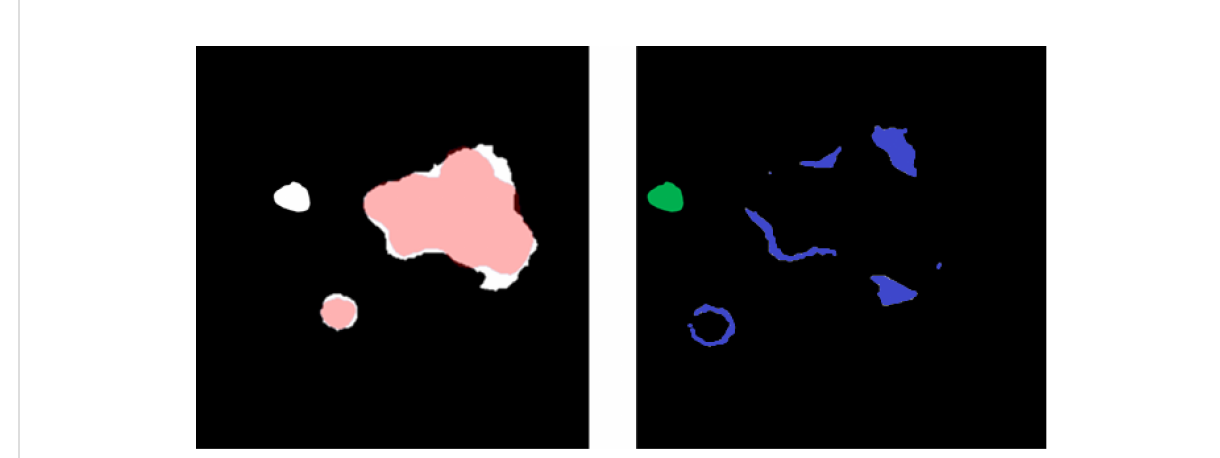
FIGURE 5 (Left) Overlay between predicted (white) and ground-truth (red) disease segmentations. (Right) Subtraction of the predicted and ground-truth disease segmentation and over-segmentation of the disease volume (blue) and unconnected erroneous false-positive region (green). The sum of blue and green is a false-positive